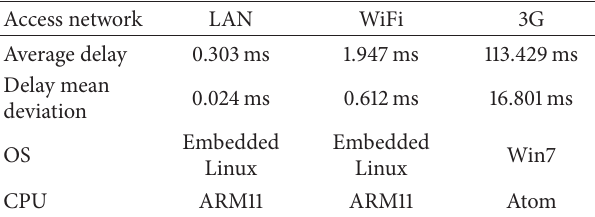
Table 3: The status description of each device.